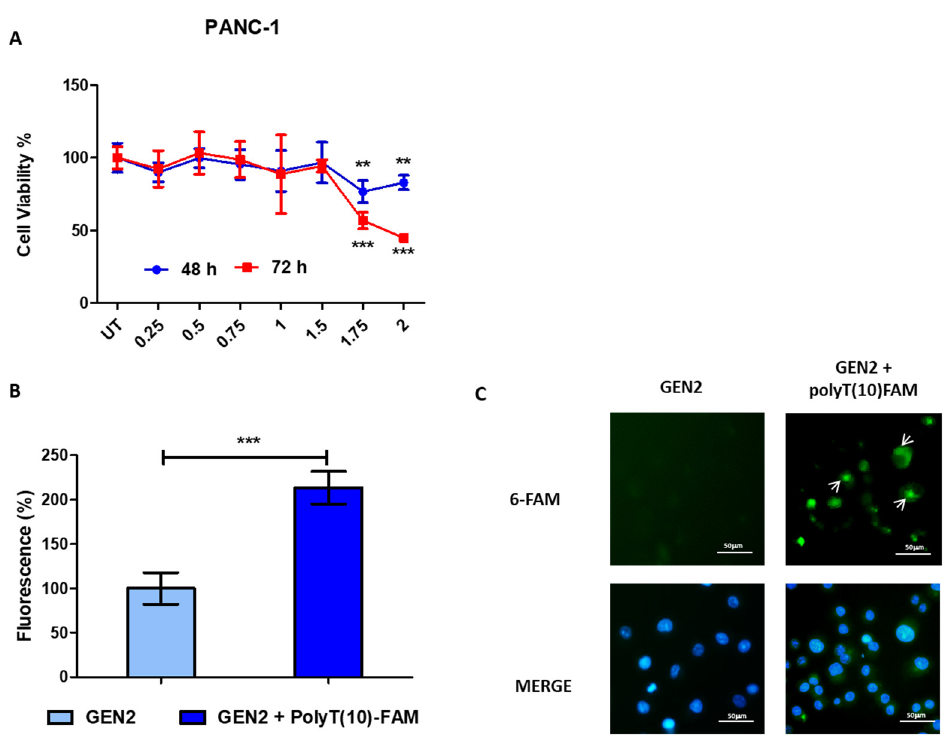
Figure 3. Biological activity of GEN2-AuNPs. ( A ). PANC-1 pancreas cancer cell lines were seeded in 96-well plates, incubated with GEN2-AuNPs for 48 and 72 h at the concentrations indicated, ranging from 0.25 to 2 nM, and the viability was assessed. The values of treated cells were normalized with untreated controls and reported as mean ± SE. ( B ) The PANC-1 pancreas cancer cells were incubated with GEN2 -AuNPs-polyT(10)FAM for 24 h. The fluorescence was measured with a multi-well plate reader and normalized to that of control (GEN2) and reported as mean ± SD. ( C ) Representative fluorescence images of PANC-1 cancer cells treated with GEN2 and treated with GEN2-polyT(10)FAM. FAM in green and nucleus are labeled in blue by Hoechst staining. Statistical analysis was performed using one-way ANOVA (each group vs. control). (*** p < 0.001, ** p <